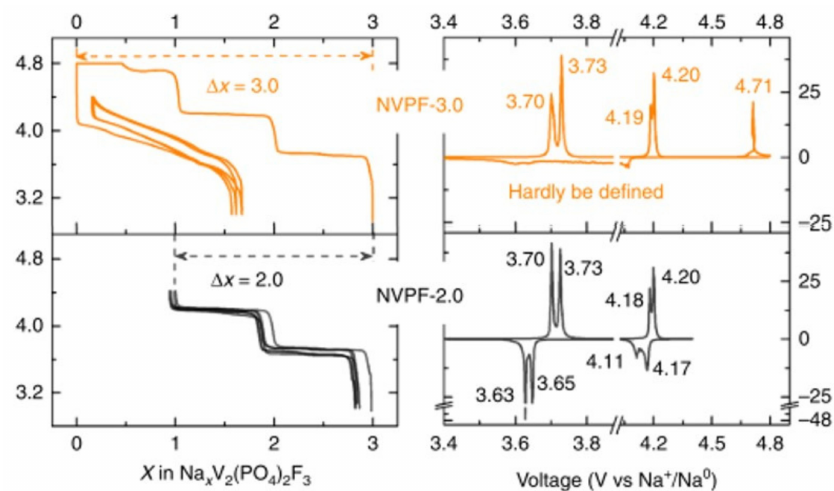
Figure 8. Galvanostatic electrochemical voltage-composition data of Na 3 V 2 (PO 4 ) 2 F 3 at C/10 per exchanged ion and the corresponding derivative curve in the 3.0–4.4 V or 3.0–4.8 V voltage range adapted from ref. [51]. Reproduced with permission from Guochan Yan et al., Nature Communica- tions; published by Springer Nature,